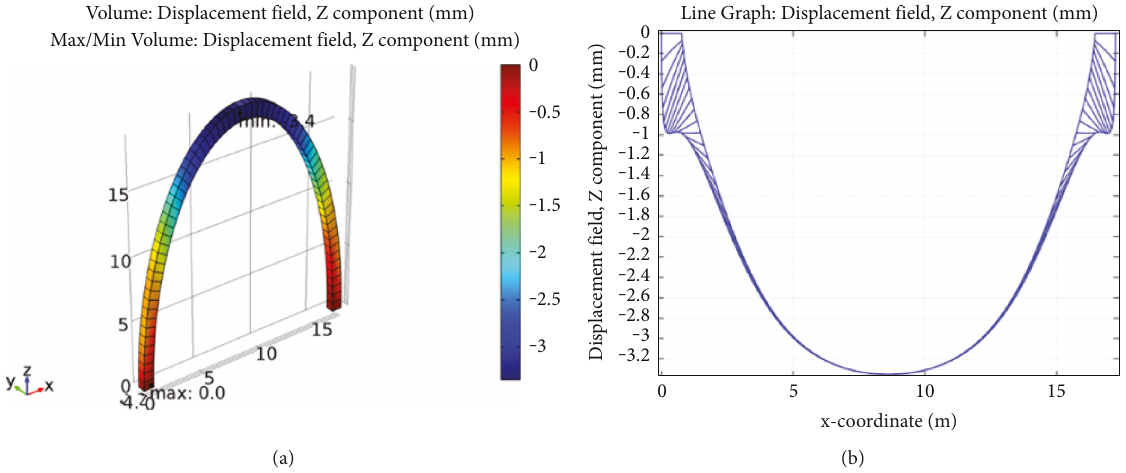
Figure 10: z -component of the displacement of the ringstone: (a) the field of deflection and (b) the arch’s deflection